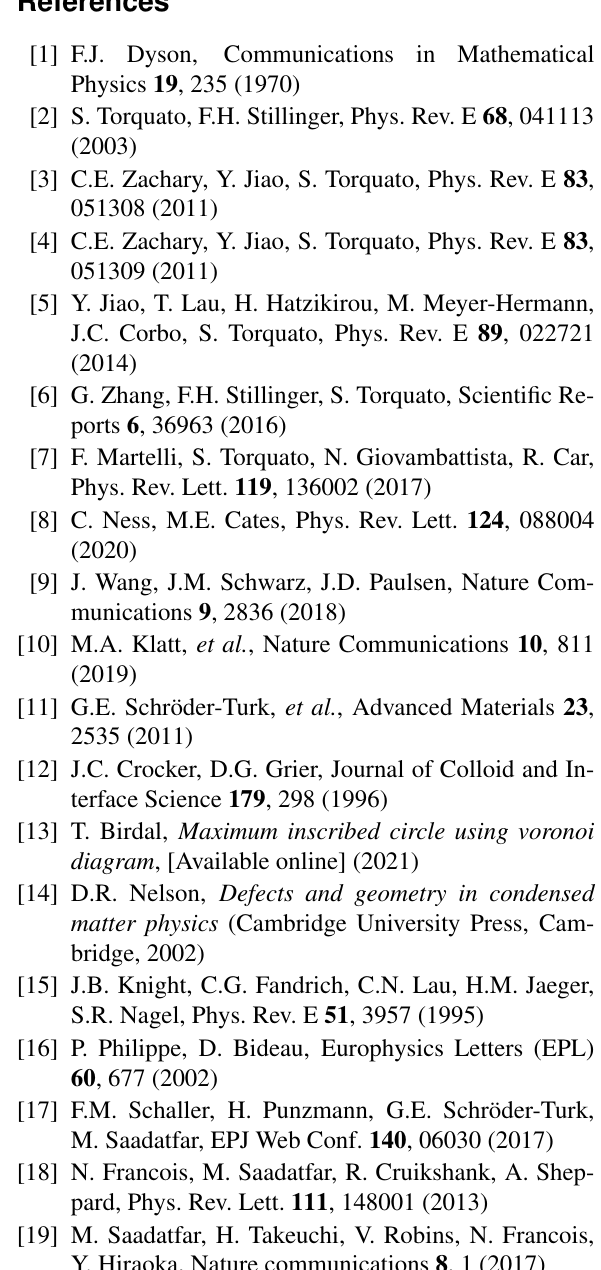
the global packing fraction φ . For a perfect 2D hexagonal system, we obtain φ ≈ 0 . 904, which is acceptably close to its theoretical value of φ lattice ≈ 0 .